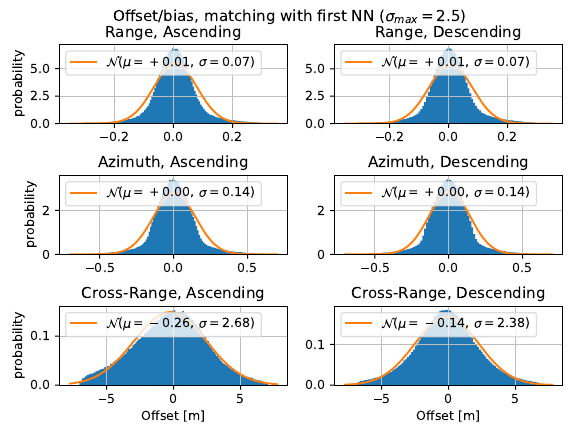
Figure 9. Offsets (biases) in matching, based on the first Nearest Neighbour, in radar coordinates.